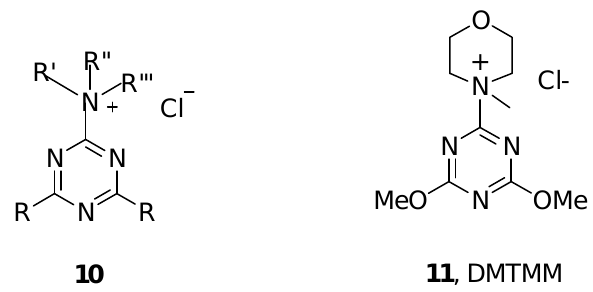
Figure 3. Structure of triazinylammonium salts.